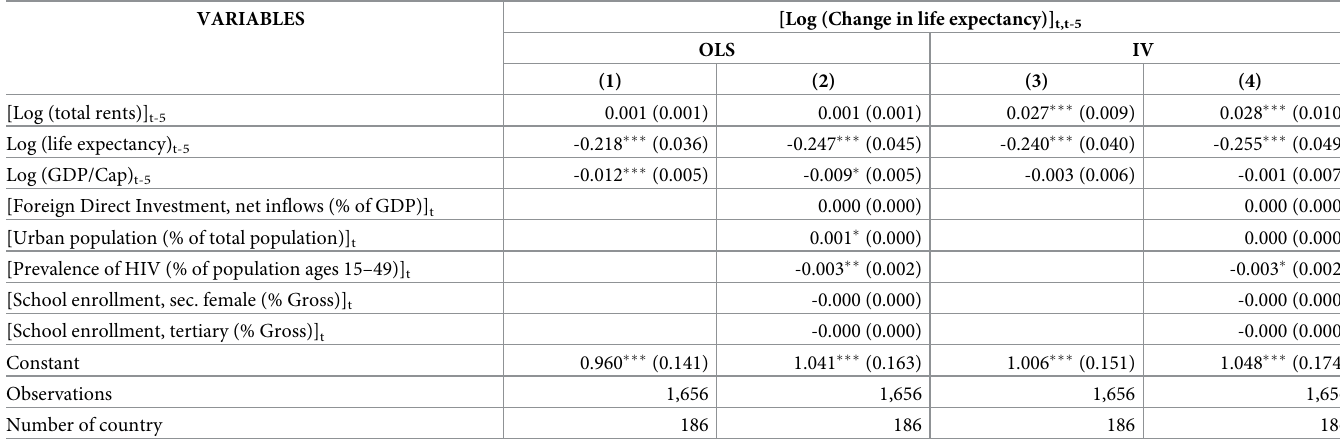
Table 3. Causal impact of rents on changes in life